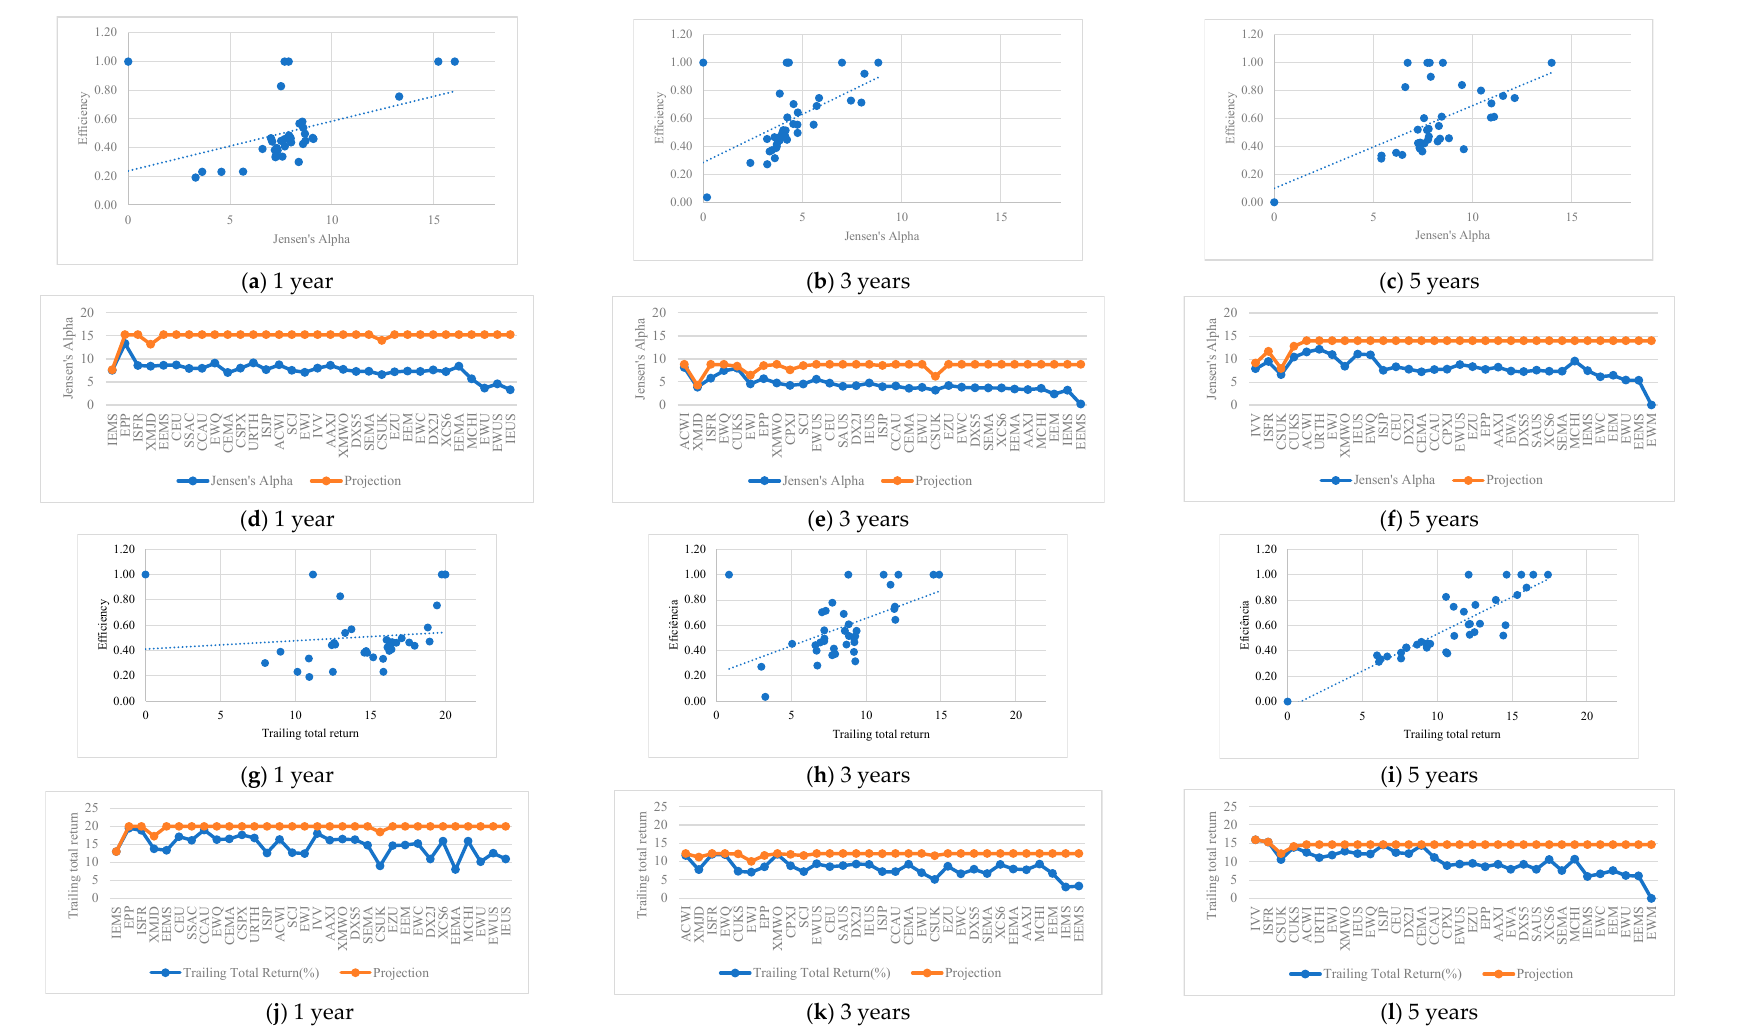
Figure 3. Efficiency scores vs. inputs and projections (ETFs are ordered in decreasing order of efficiency) for the different time horizons–M2.